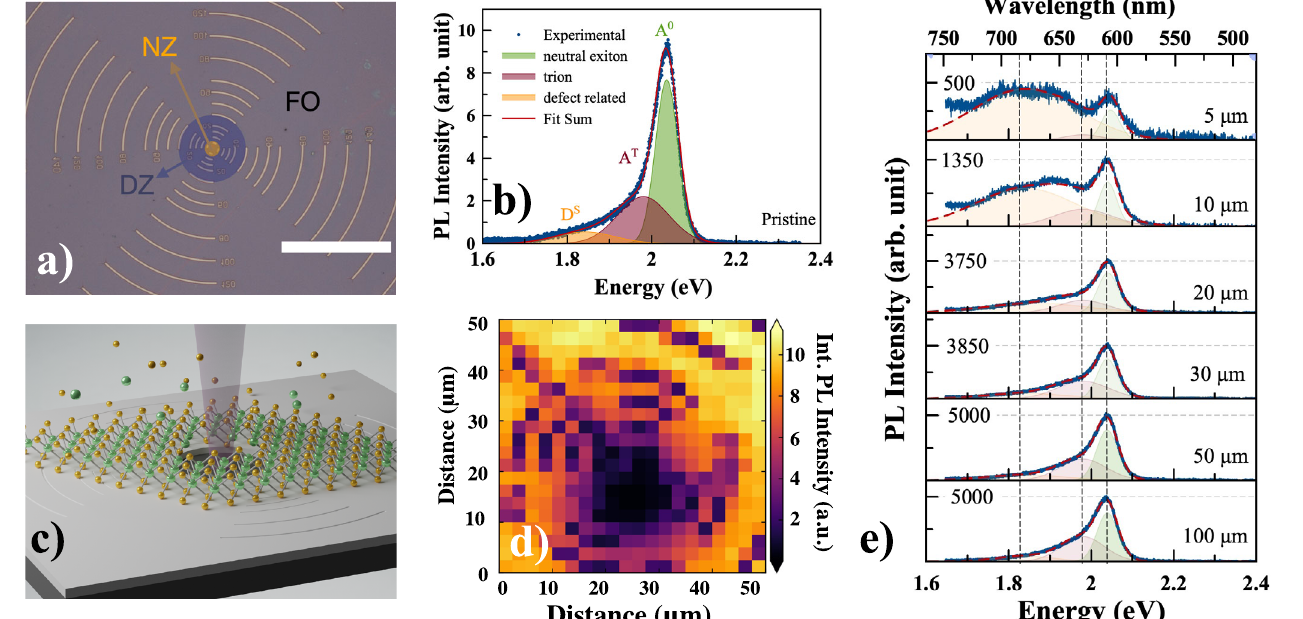
Fig. 1 Steady-state photoluminescence from monolayer WS 2 samples. a Optical microscope image of a wet-transferred ML WS 2 on a pre- patterned SiO 2 /Si substrate, the scale bar is 100 µm; different shaded regions in a indicate the three identi fi ed zones — we divide the sample into the near zone (NZ), the dark zone (DZ) and the far-out zone (FO). b PL spectra of as-transferred ML WS 2 (referred to pristine) on a SiO 2 /Si substrate, c Schematic drawing of the FIB lithography process on a WS 2 /SiO 2 /Si sample, d PL mapping of a FIB-milled WS 2 /SiO 2 /Si sample (Ga + beam current is 30 pA) and e PL spectra measured at different locations, with the distance from the FIB milling position labelled on each spectrum. The green, red, and orange colours in b and e indicate the three emission peaks originating from neutral exciton (A 0 ), trion (A T ) and defect-state (D S ), respectively. The peak wavelengths are marked with vertical dashed lines, and the maximum PL intensity values at each position are noted in e , highlighting the decrease of the PL intensity with decreasing the distance from the FIB-milled